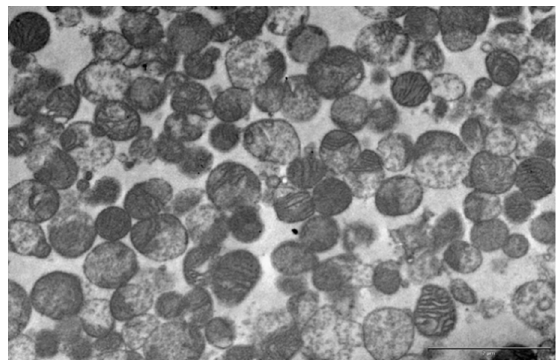
Figure 1. Representative transmission electron microscopy of the mitochondria-enriched fraction from brown adipose tissue (BAT) of acute low (0.4 IU) dose insulin-treated rats. Scale bar = 2 µm.